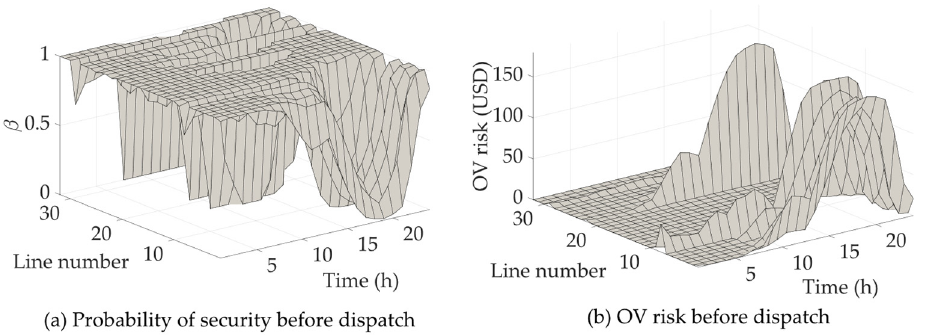
Figure 7. Security Probability and OV risks before